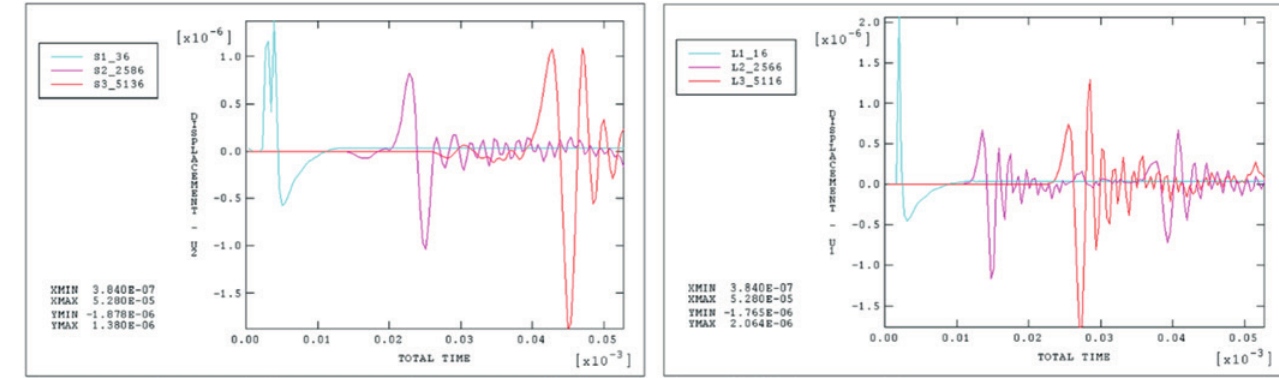
ment model are lower than the values from the experiments. The variation of the velocities with respect to the undamaged reference values is presented on Table 5. Velocities decay computed using the finite element model was not consistent with the experimental results. Mortar 2 showed a higher sensitivity to thermal damage than Mortar 1, contradicting the experimental results. This incon- sistency in the results may be a consequence of some limitations of the model used in the analysis – basically, the model used does not take into account microcrack formation and development due to loading. In addition, due to the relatively short exposure to the